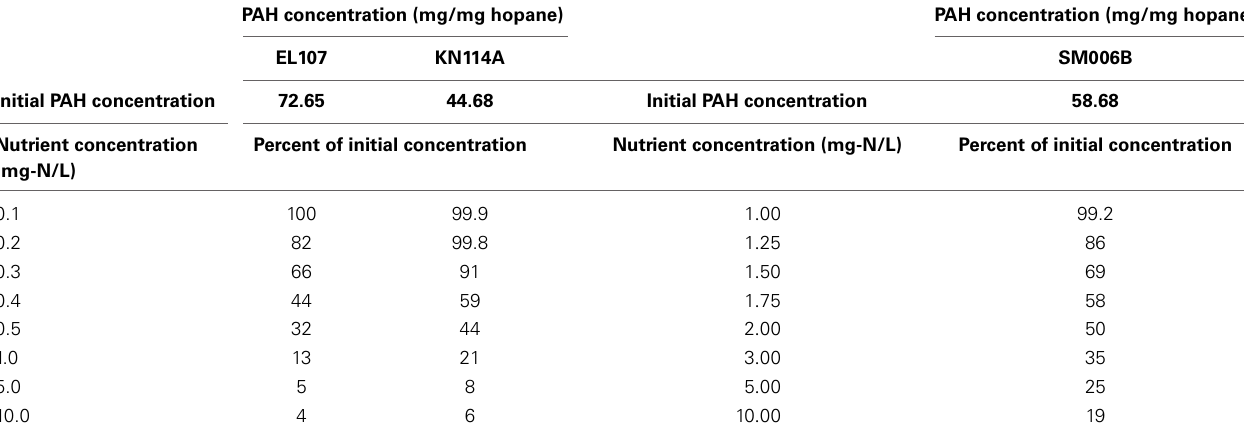
Table 4 | PAH concentrations as percentage of the initial concentrations for different nutrient concentrations at t = 168